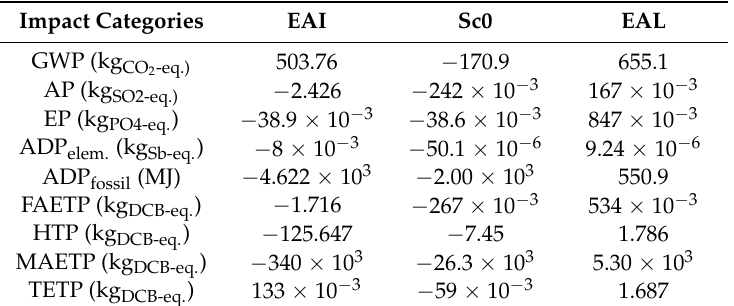
Table 5. Comparison of the environmental impacts for the Portuguese incineration plant and the European standards for incineration and